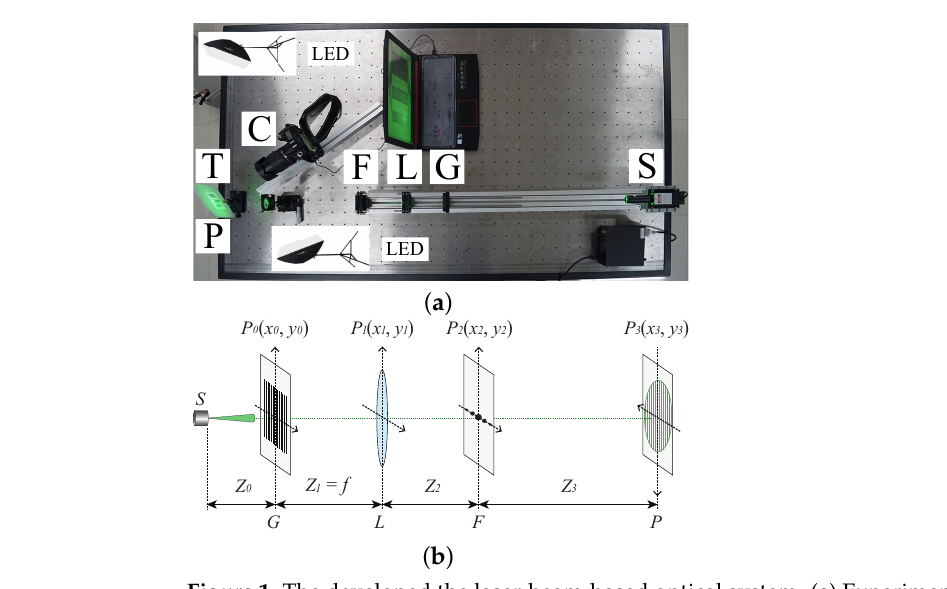
Figure 1. The developed the laser-beam-based optical system. ( a ) Experimental setup. S : CW laser source; G : grating; L : Fourier-transform positive lens; F : spatial-frequency filter; P : observation plane; T : target on the observation plane; C : CCD Camera connected to a computer; LED : LED light for accurately adjusting the background illuminance. ( b ) Sketch of the sinusoidal optical signal